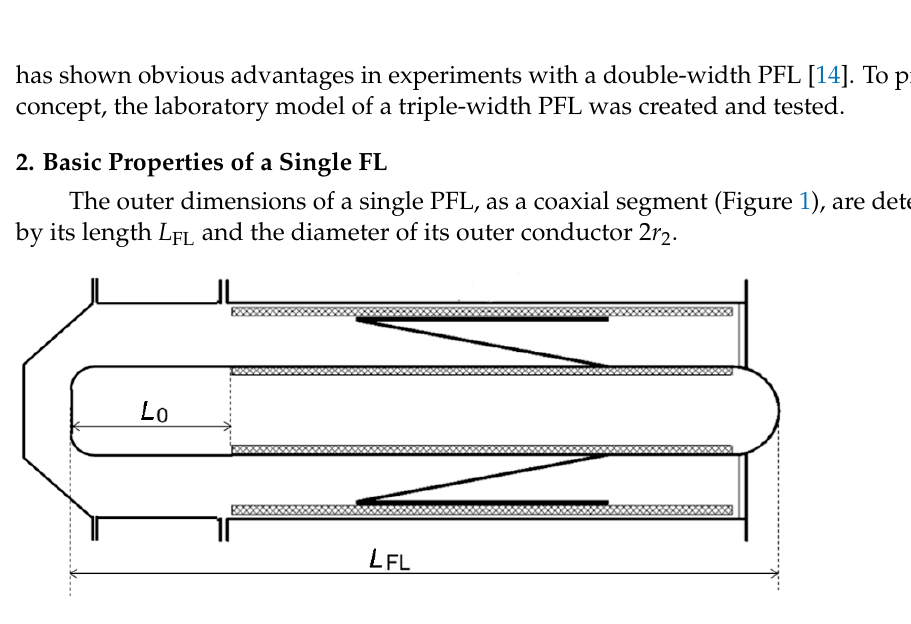
Figure 1. Geometry of PFL with built in Tesla transformer. The main part of the length L FL is a Tesla transformer range (hatched area shows the magnetic cores). An additional piece of coaxial line L 0 can be used to increase the formed voltage pulse width.